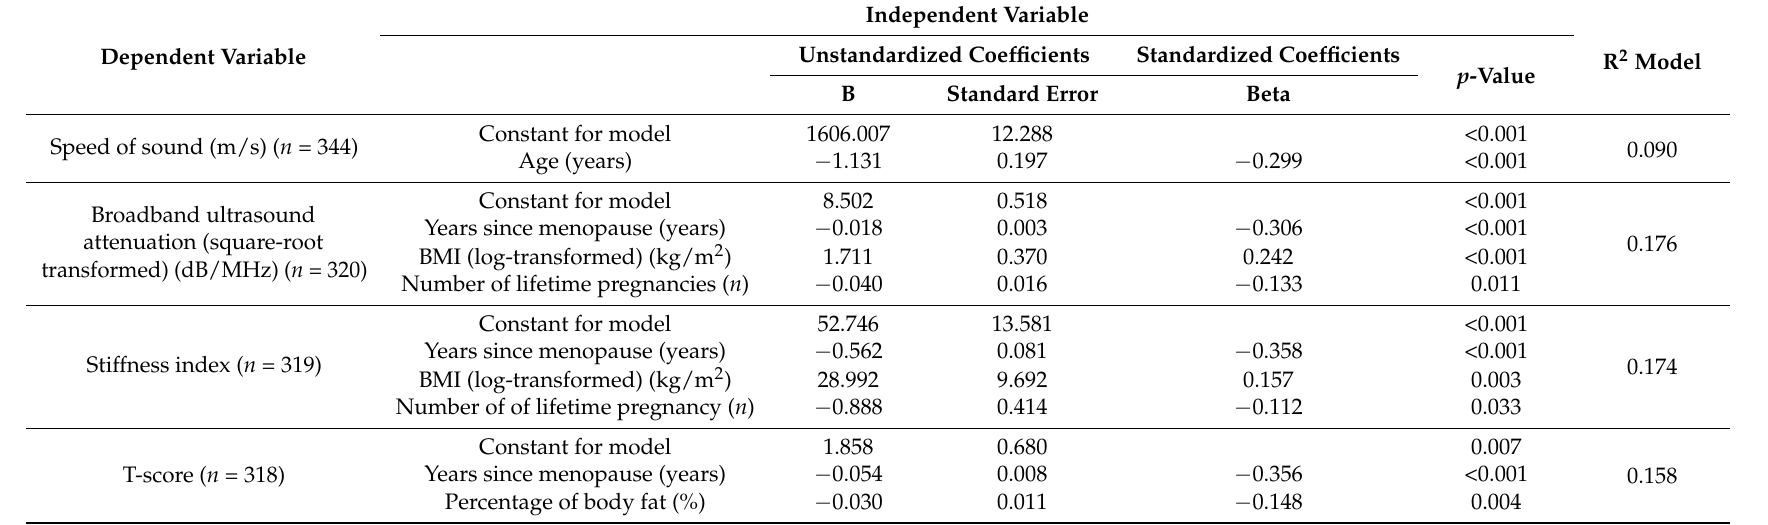
Table 3. Stepwise multiple linear regression between QUS indices and variables of